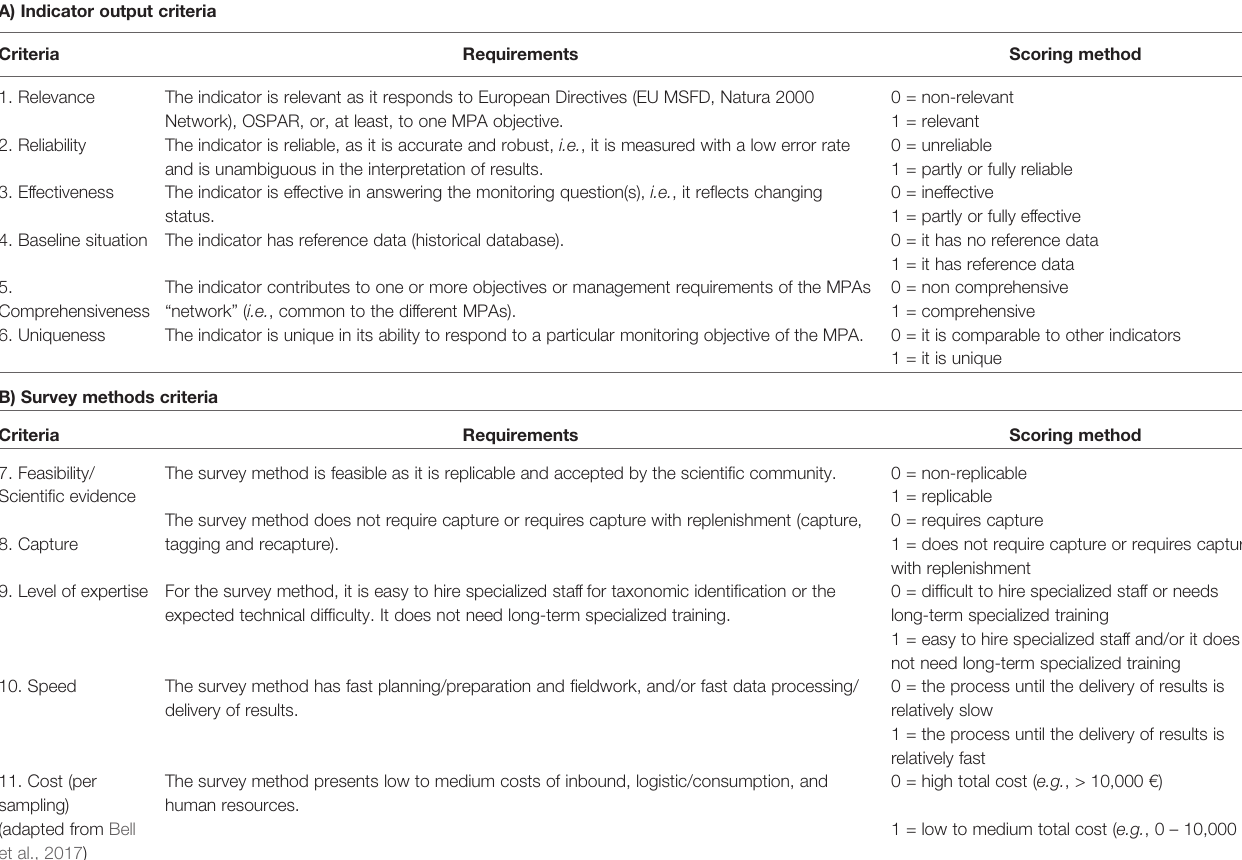
TABLE 1 | Validated indicator performance criteria and the scoring method